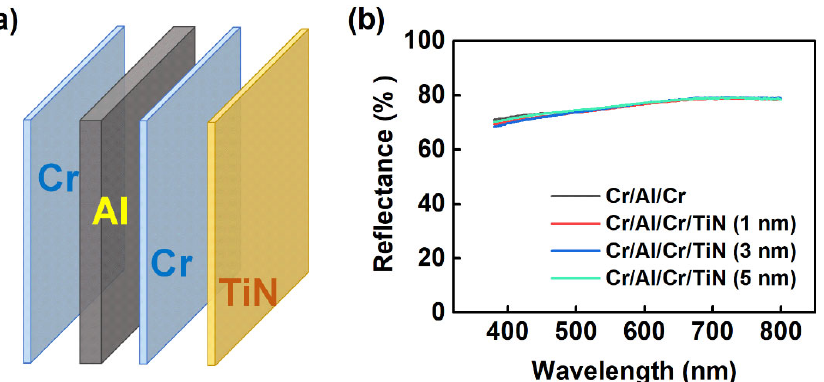
Figure 1. ( a ) Schematic structure of the composite anode; ( b ) Reflectance spectra of the Cr/Al/Cr/TiN anodes with different thicknesses of TiN.